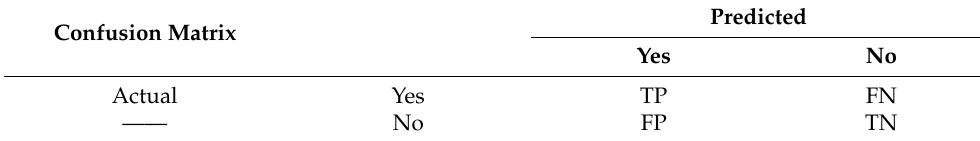
Table 1. Confusion